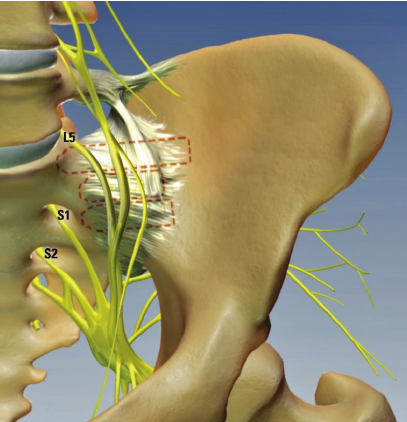
Figure 1: A three-dimensional representation of the lumbar spine, sacrum, and ilium. Red dashed outlines depict common positioning of three iFuse implants across the sacroiliac joint. Of the neural structures shown, the L5, S1, and S2 nerves (labeled in the figure) are at greatest risk of injury during such